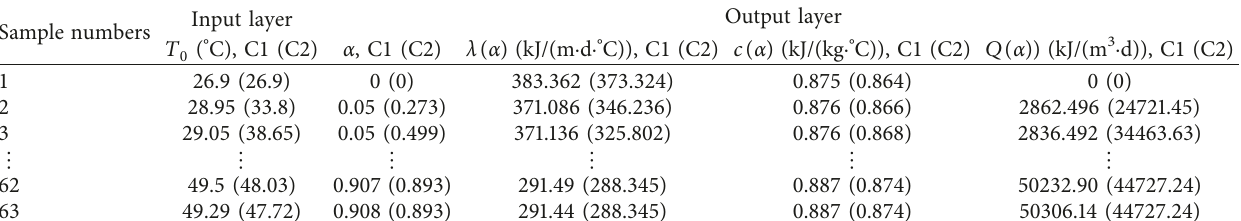
Table 7: The thermal parameters calculated by Method